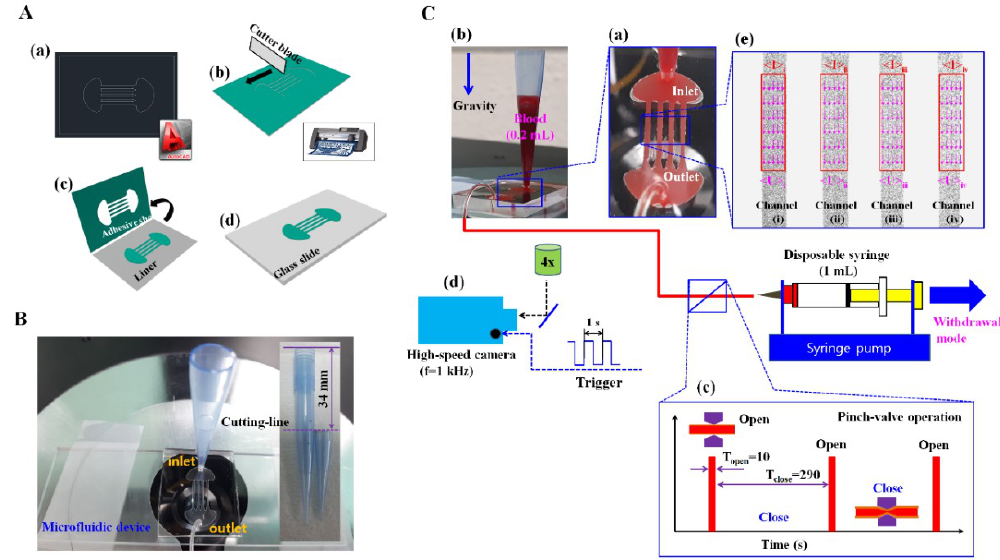
Figure 1. Details of a master mold using an adhesive sheet and a conical pipette tip, and schematic diagram of a proposed method for quantifying red blood cells (RBCs) aggregation and erythrocyte